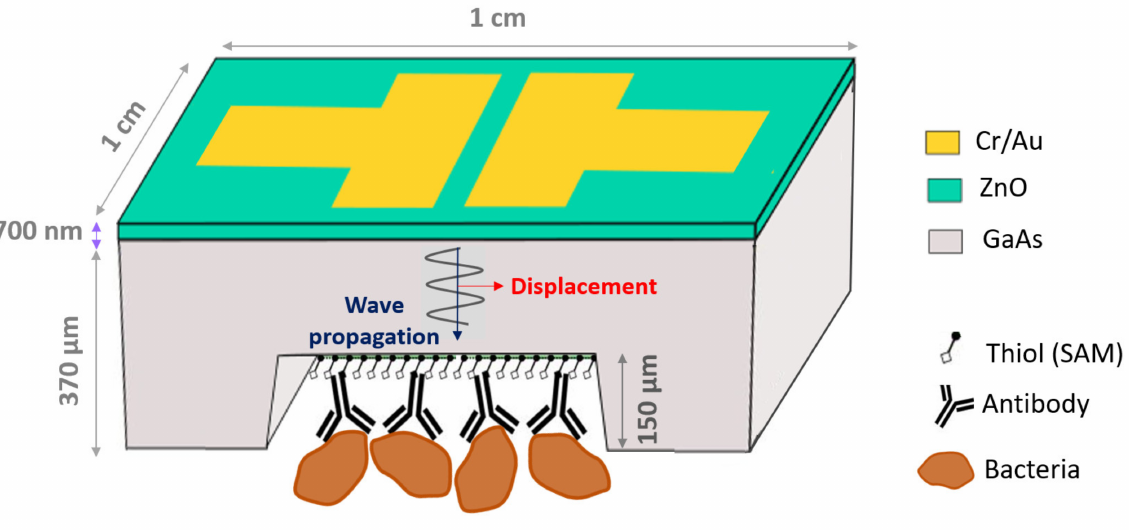
Figure 1. Architecture of ZnO/GaAs BAW biosensor (not to